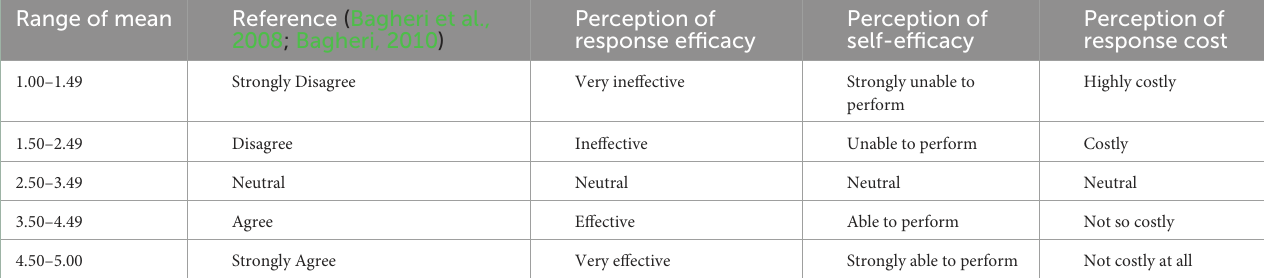
TABLE 2 Categorization of the mean of responses for the perception of adaptation efficacy. Range of